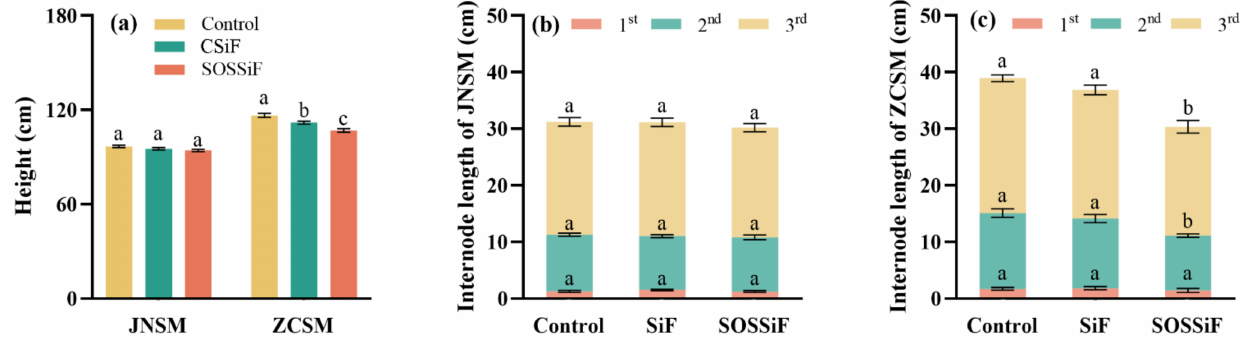
Figure 5. Effect of different Si treatments on morphological index of rice plants. ( a ) height, ( b ) internode length of JNSM, ( c ) internode length of ZCSM. Different small letters above the histogram of the same rice variety or the same node indicated significant